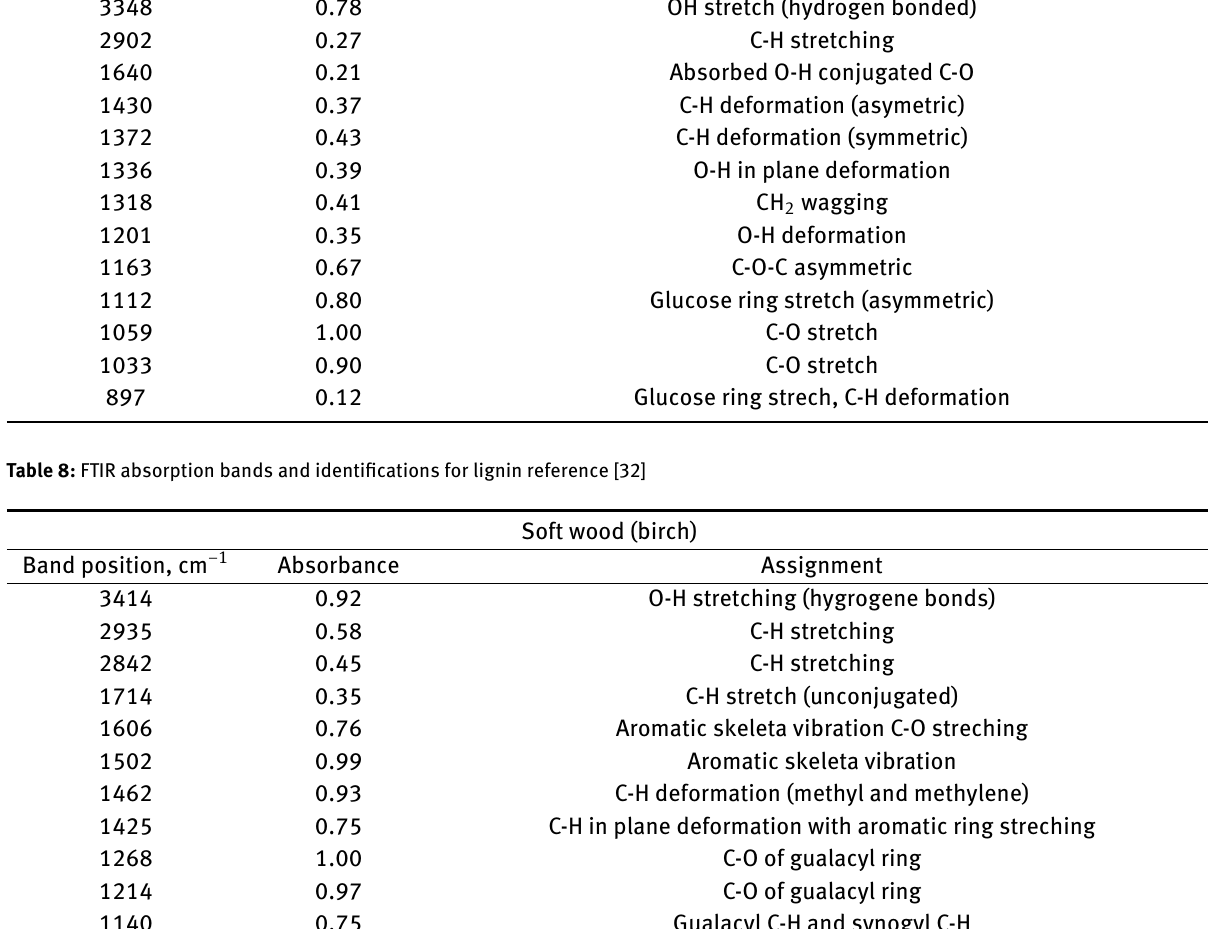
Table 7: FTIR absorption bands and identifications for cellulose reference [32] Band position, cm −1